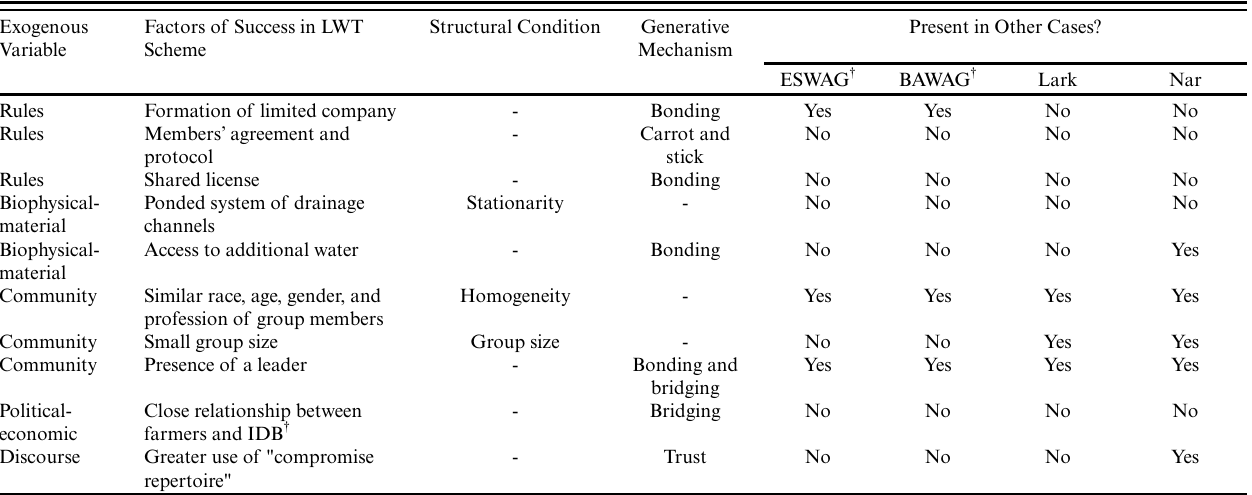
Table 2 . Nine factors contributing to the success of the Lincoln Water Transfer Limited (LWT) comanagement scheme and the structural conditions and generative mechanisms derived from them; displayed in relation to the five sets of exogenous variables of the politicized institutional analysis and development framework and compared with the other four case studies.